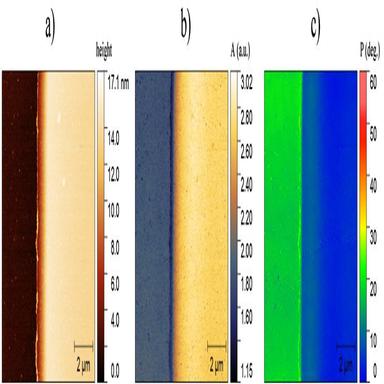
SM sample (Si as substrate and Pt thin film). Imaging was performed at the edge of the Pt film; (a) AFM topography; (b) s-SNOM 3rd harmonic amplitude; (c) s-SNOM 3rd harmonic phase.